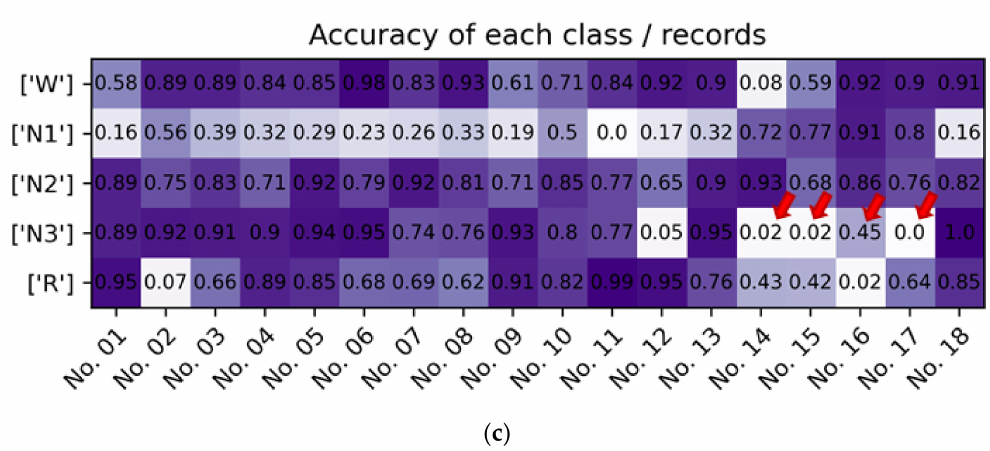
Figure 6. Classification metrics of the clinical dataset (colored by PSG system). ( a ) Average metrics of different system groups. The Anova p value showed no significant different across different systems ( p > 0.05); ( b ) accuracy of individual records. Some records showed exceptionally low accuracy compared to others (red arrow); ( c ) accuracy of each class/record. All of the records showing exceptional accuracy also have very low N3 accuracy.